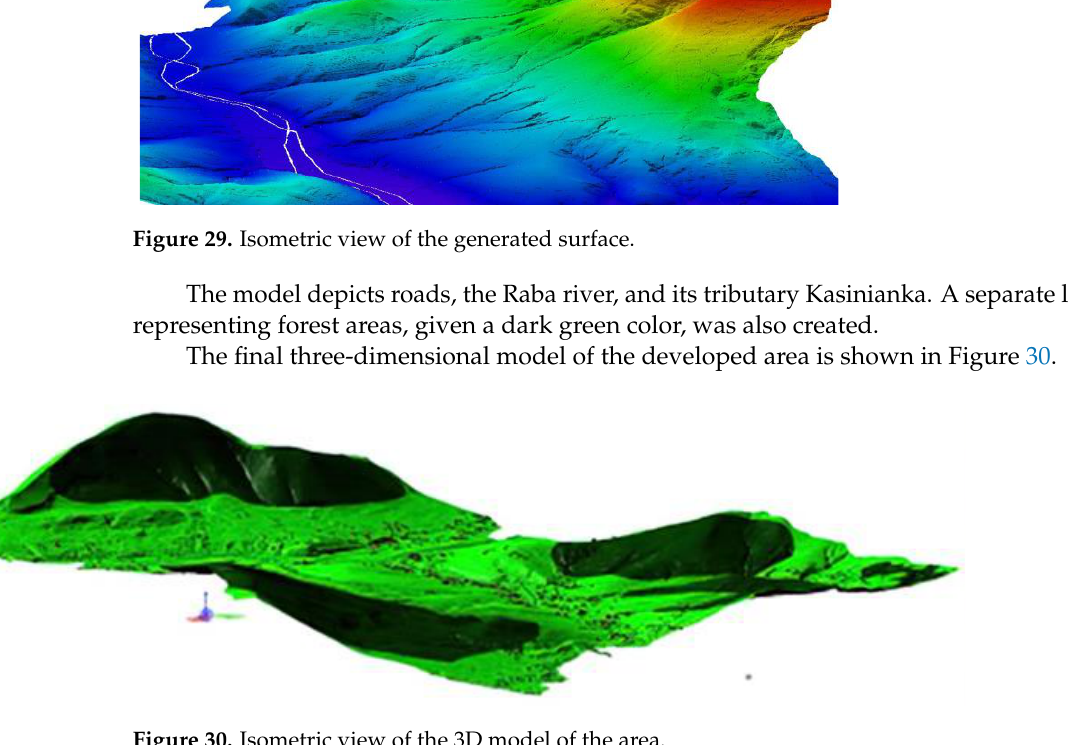
Figure 30. Isometric view of the 3D model of the area.